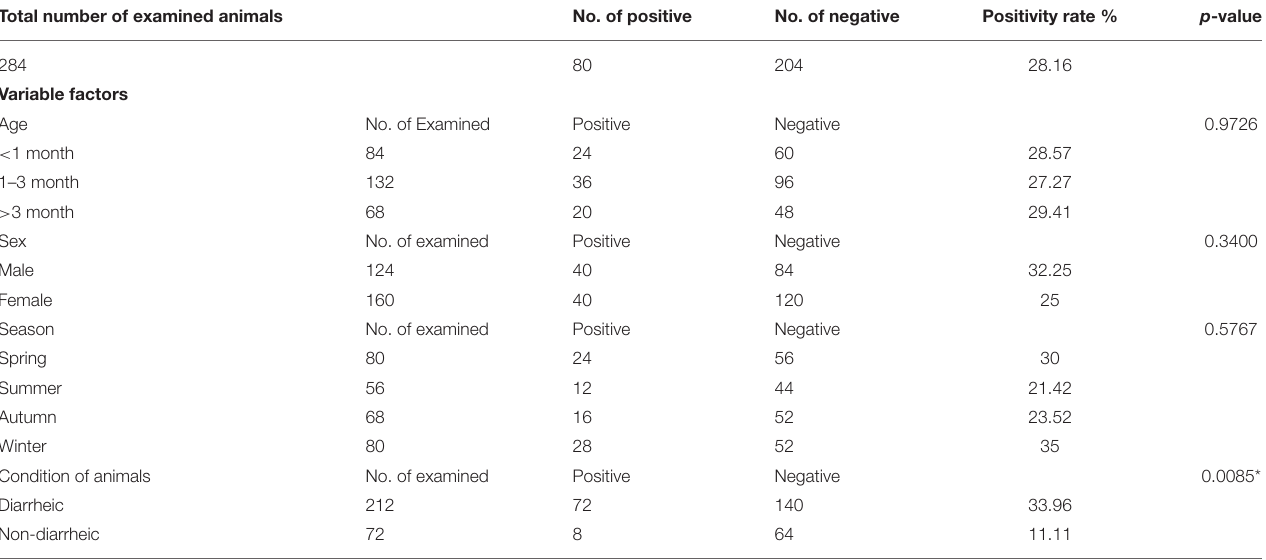
TABLE 7 | Summarizes the data of the possible associations between the occurrence of Cryptosporidium spp. in buffalo calves and the potential explanatory individual variable factors of these detected species. Total number of examined